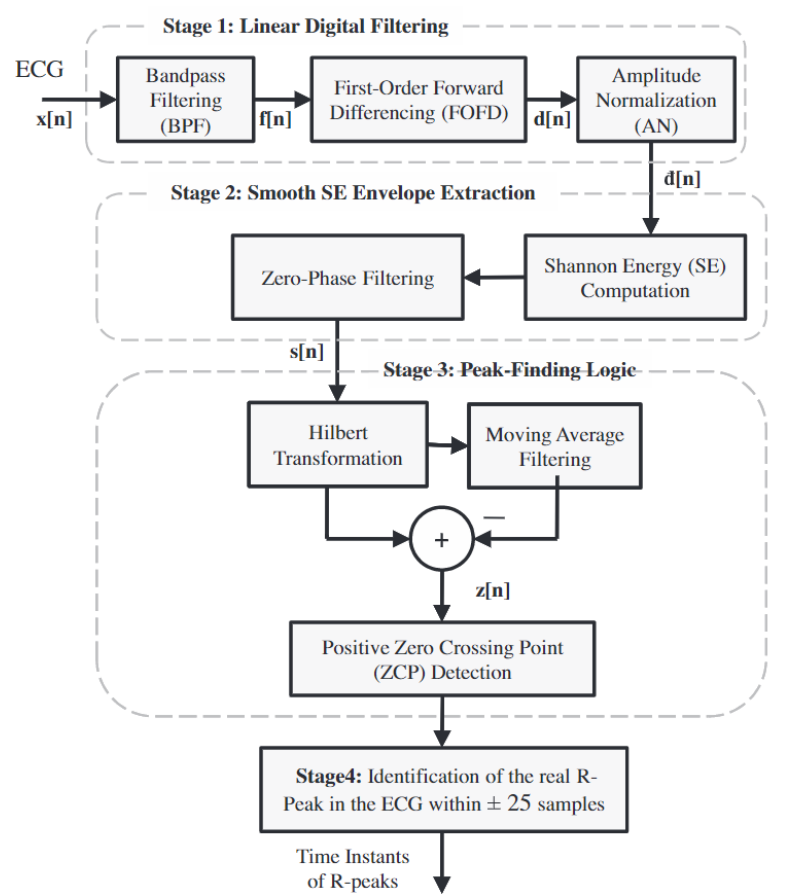
Figure 15. SEEHT R-peak detection